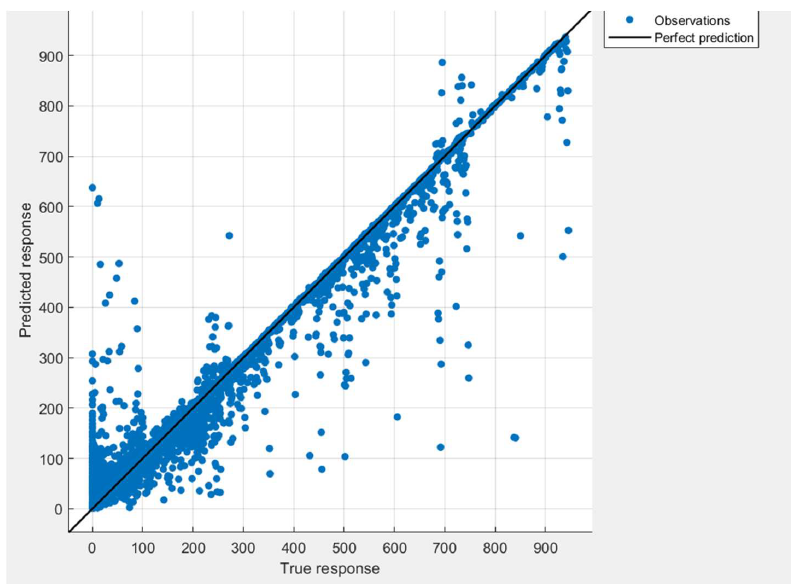
Figure 6. Prediction trend for interval E.